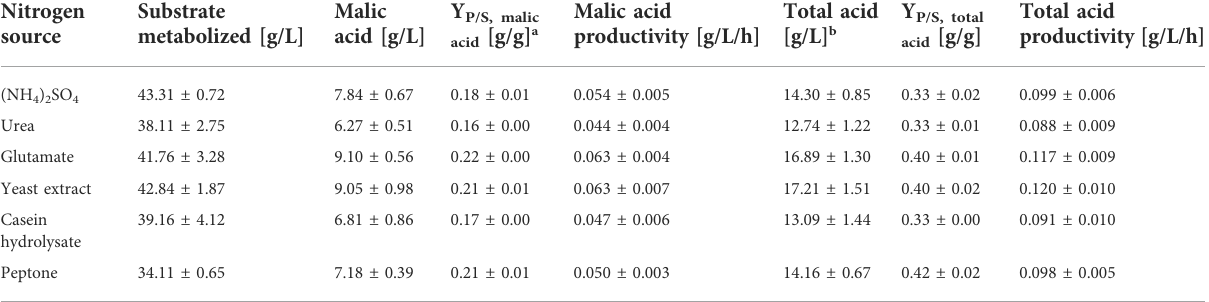
TABLE 3 Fermentation results for cultivations of A. oryzae with different nitrogen sources after 144 h. Values are means ± standard deviation, n = 3. Nitrogen